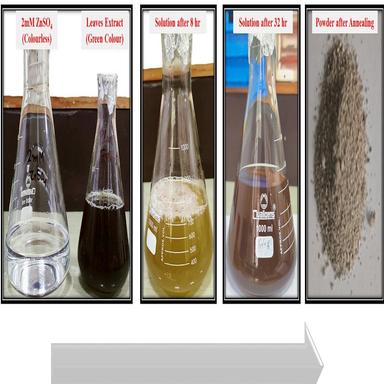
he colour of foliage extract, its agitated mixer solution with zinc sulphate and as received powder after lyophilized the solution.